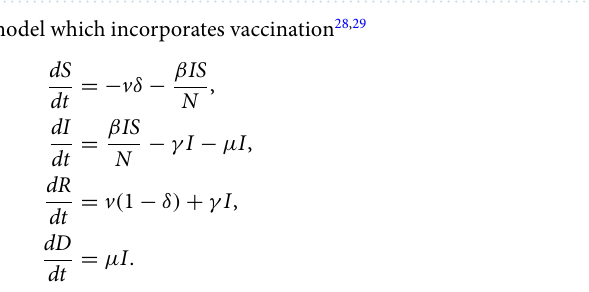
Figure 8. Forecasting of of the number of Covid-19 infections for France, the United Kingdom, Germany, and South Korea under various vaccination schedules. Here, “ 12% ", “ 20% ", and “ 38% " mean 12%, 20%, 38% of the population is vaccinated,